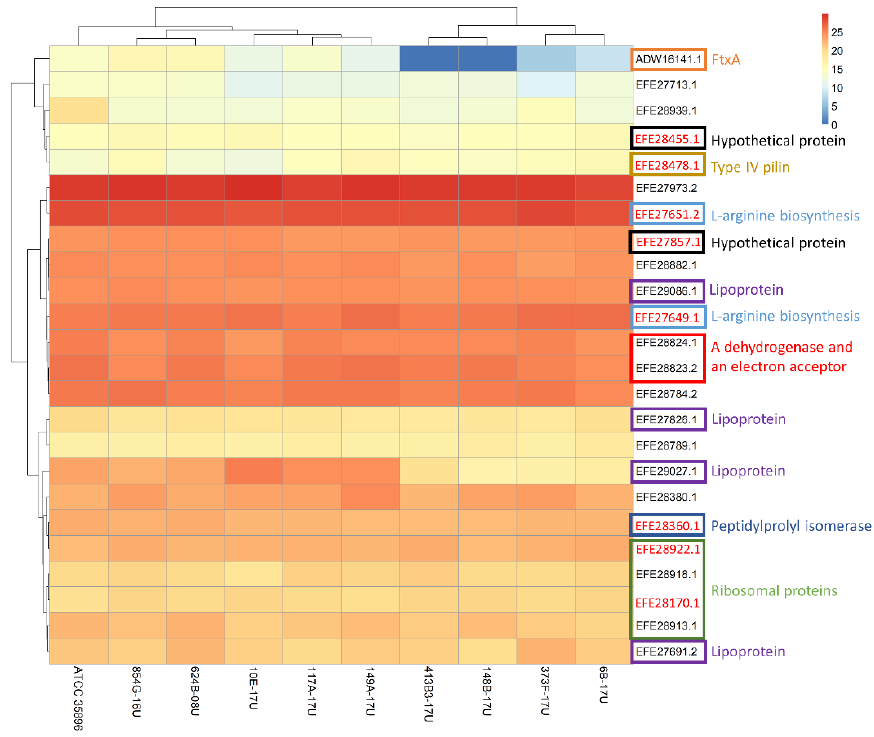
Figure 3. Heatmap of normalized abundance for EV proteins. The colors in the map display the mean value for log2-transformed normalized abundance value plus one for the individual proteins (represented by a single row) within each experimental group (represented by a single column). Expression values are shown as a color scale, with higher values represented by red and lower represented by blue. The EV proteins that were expressed at consistent levels ( p > 0.05) among all strains are indicated with red text. Color-frame boxes and short explanations with the same color were given for proteins with consistent expressions as well as proteins with interaction confidence of more than 0.9 based on STRING